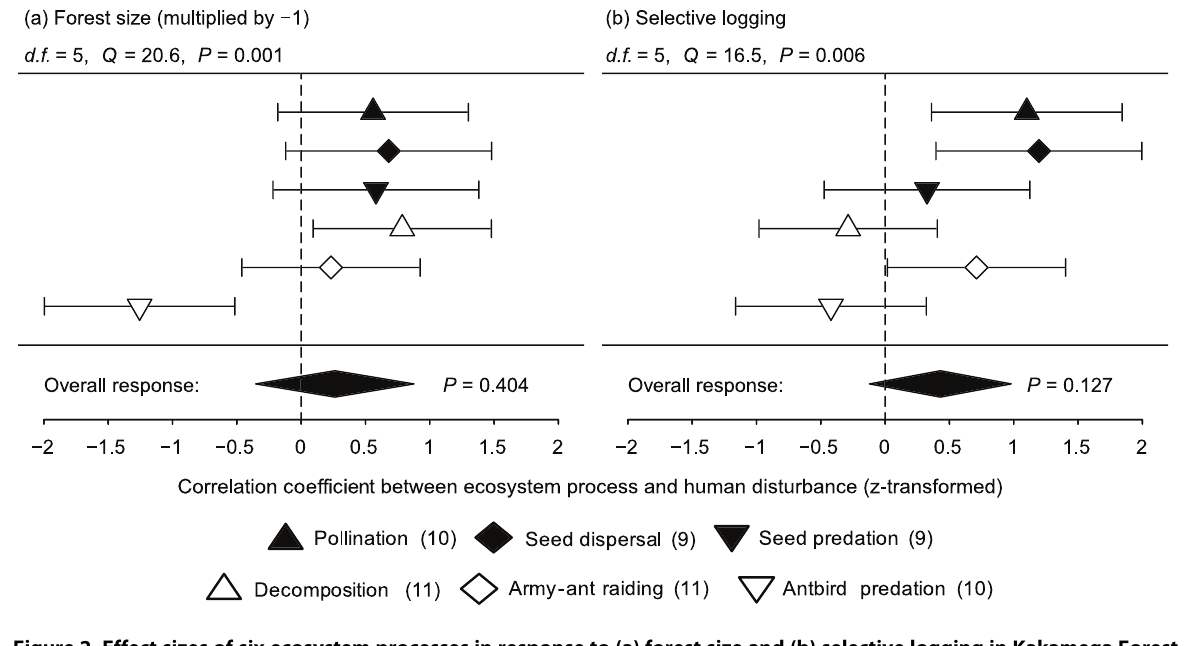
Figure 2. Effect sizes of six ecosystem processes in response to (a) forest size and (b) selective logging in Kakamega Forest, Kenya. Human disturbance increases from low to high values (forest size was multiplied by 2 1). Given are z -transformed correlation coefficients and their 95% confidence intervals for all pair-wise correlations between the respective ecosystem process and forest size and selective logging, respectively. The number of study sites for each process is indicated in parentheses. Overall effect sizes from a random-effects models (DSL approach) are displayed as diamonds. Residual heterogeneity was tested with Cochran’s Q -test. doi:10.1371/journal.pone.0027785.g002 PLoS ONE |